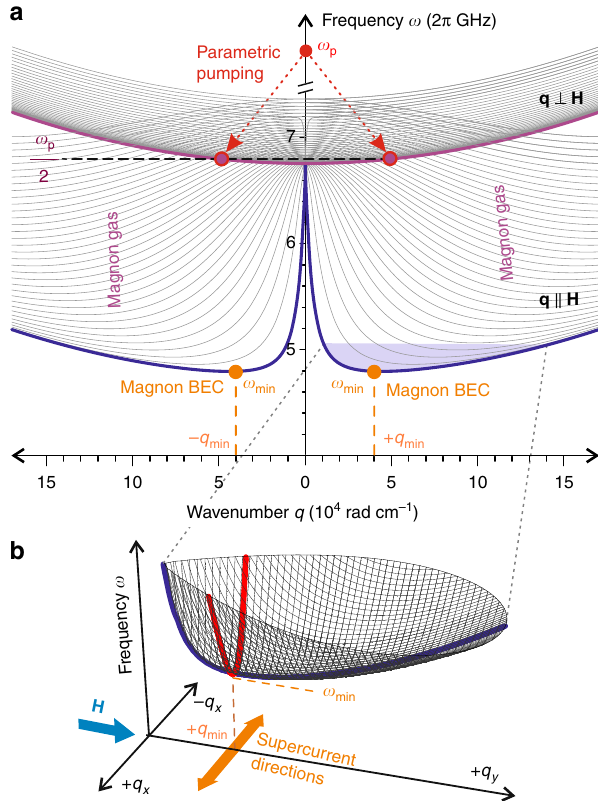
Fig. 2 Magnon spectrum. a Magnon spectrum of a 5.6- μ m-thick YIG fi lm magnetized in plane by a bias magnetic fi eld H = 1690 Oe is presented for the wavevectors q perpendicular (± q ⊥ H ) and parallel (± q || H ) to the applied fi eld. For both wavevector orientations the fi rst 35 thickness modes are shown. The red arrows illustrate the process of injection of magnon pairs at ω p /2 frequency by means of parallel parametric pumping. Thermalization of the parametrically overpopulated magnon gas leads to the formation of Bose – Einstein condensates in two symmetric minima of the frequency spectrum ω ( q ) at q = ± q min (with q min || H ). Inset b shows the 3-dimensional view of a bottom part of the spectrum (the lowest fundamental mode n = 0 within the shaded violet area in a ) calculated in the range up to 200 MHz above the ω min . The red curve shows the spectrum of magnons with ± q ⊥ H and the blue curve relates to the magnons with ± q || H . Due to the much higher (about 21 times) steepness of the red curve near ( ω min , q min ), and, thus, proportionally smaller effective masses of the corresponding magnons, the magnon supercurrents predominantly propagate in a fi lm plane across H and along the ± q x